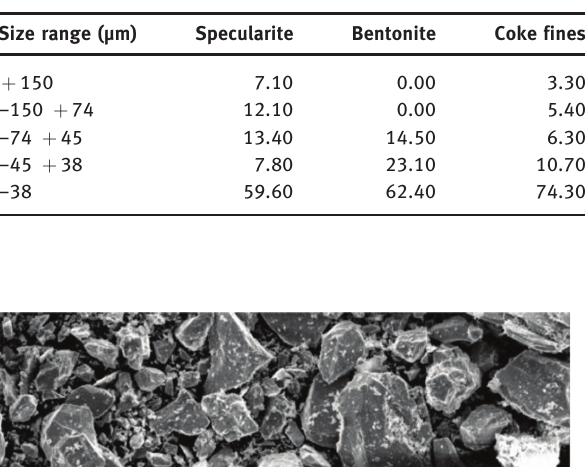
Table 2: Particle size distribution of materials used for pelletizing/mass%.